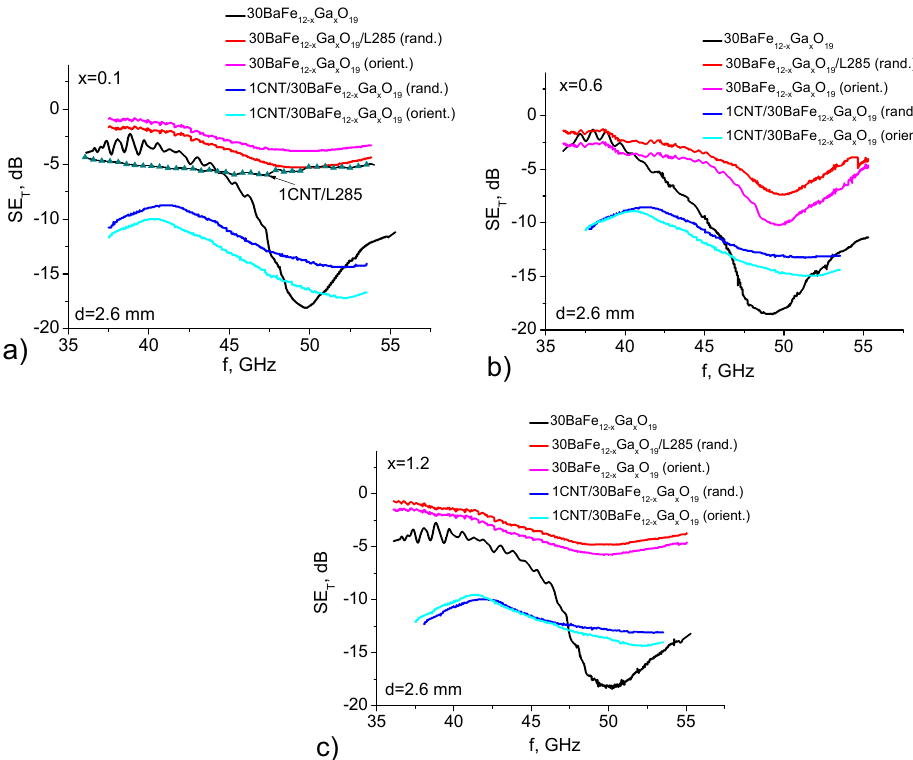
Figure 2. EMR transmission spectra for epoxy composites filled with substituted BaFe 12– x Ga x O 19 : ( a ) x = 0.1; ( b ) x = 0.6; ( c ) x = 1.2; curve marked by symbols corresponds to 1 wt.% CNT/epoxy CM.